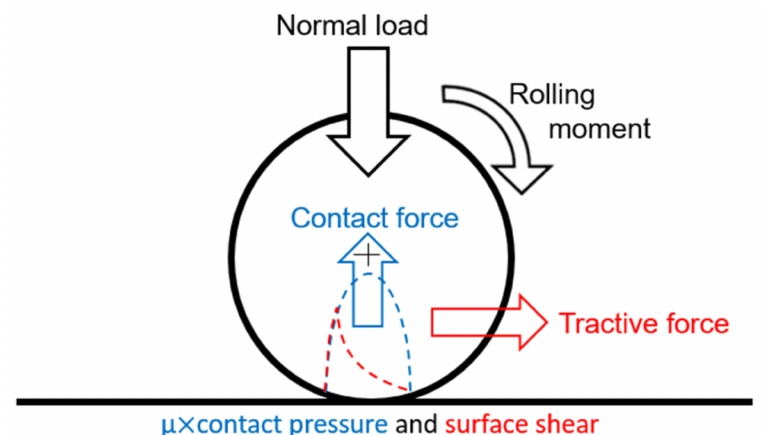
Figure 2. Rolling contact kinematics.